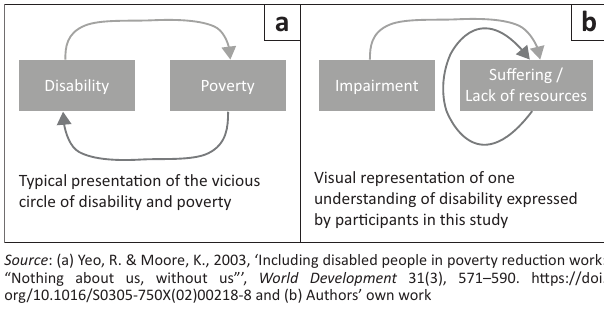
FIGURE 2: Typical and alternative presentations of the relationship of disability and